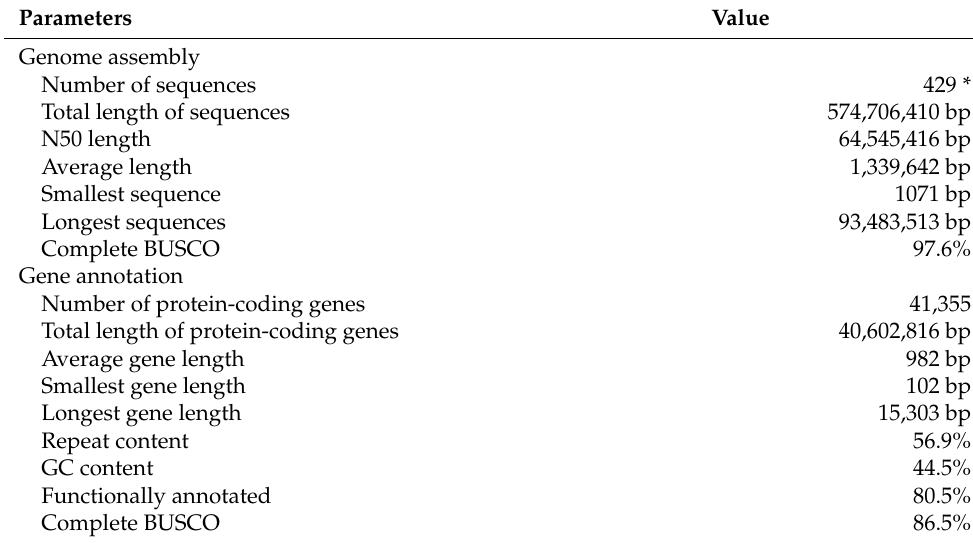
Table 1. Genome assembly and gene annotation of P. grandi fl orum .